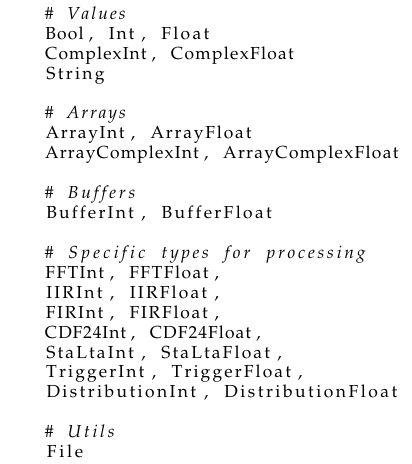
Table A1. List of data types available in the current version of